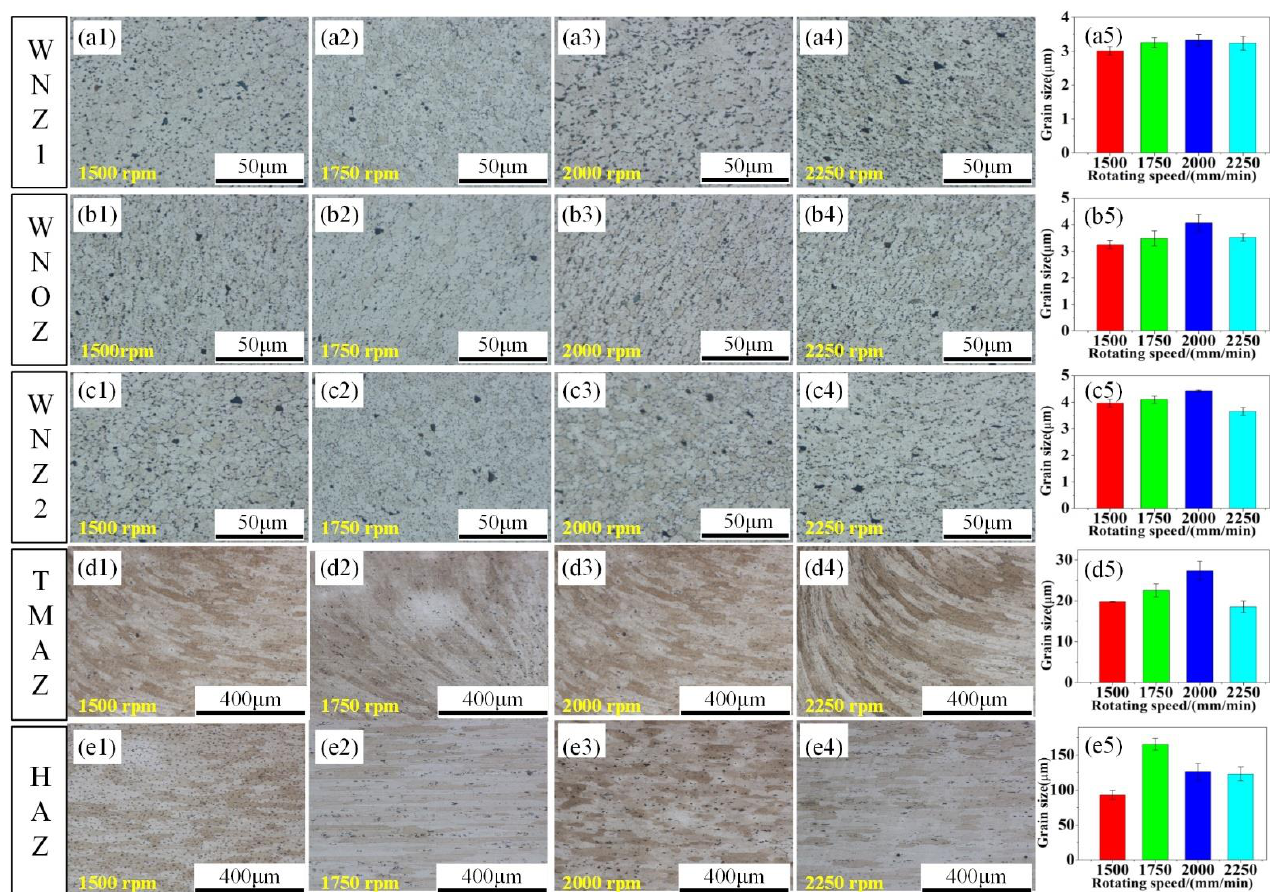
Figure 9. The microstructures and average sizes in the T-joints welded via SSFSW at different rotation speeds of the stirring pin: ( a1 )–( e1 ) 1500 rpm; ( a1 )–( e2 ) 1750 rpm; ( a1 )–( e3 ) 2000 rpm; ( a4 )–( e4 ) 2250 rpm;